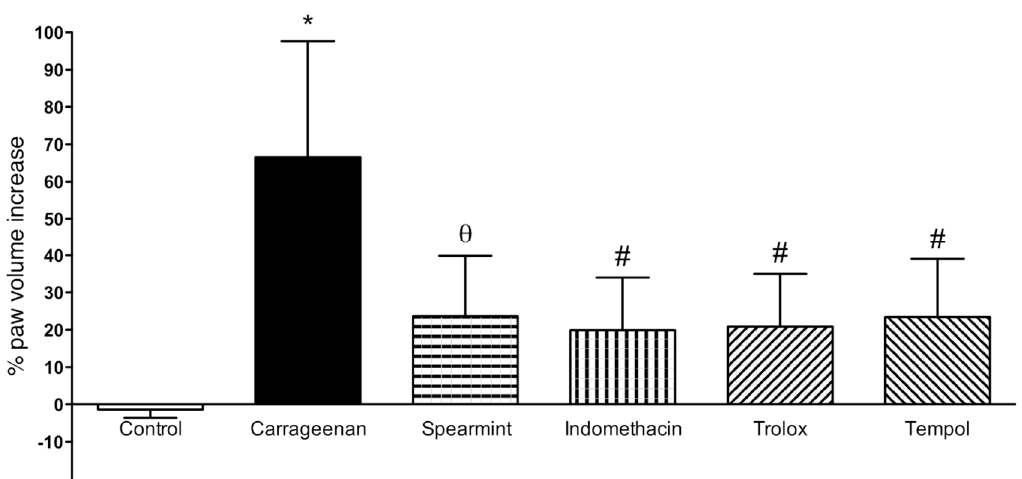
Figure 3. E ff ect of Spearmint extract administration on the paw oedema volume induced by carrageenan. Figure 3. Effect of Spearmint extract administration on the paw oedema volume induced by * p < 0.001 vs. Control; θ p < 0.01 vs. Carrageenan; # p < 0.001 vs. carrageenan. * p <0.001 vs Control; θ p <0.01 vs Carrageenan; # p <0.001 vs Carrageenan.